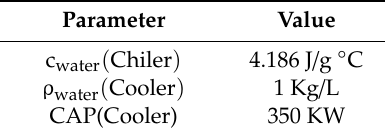
Table 5. Cooler characteristics obtained from user